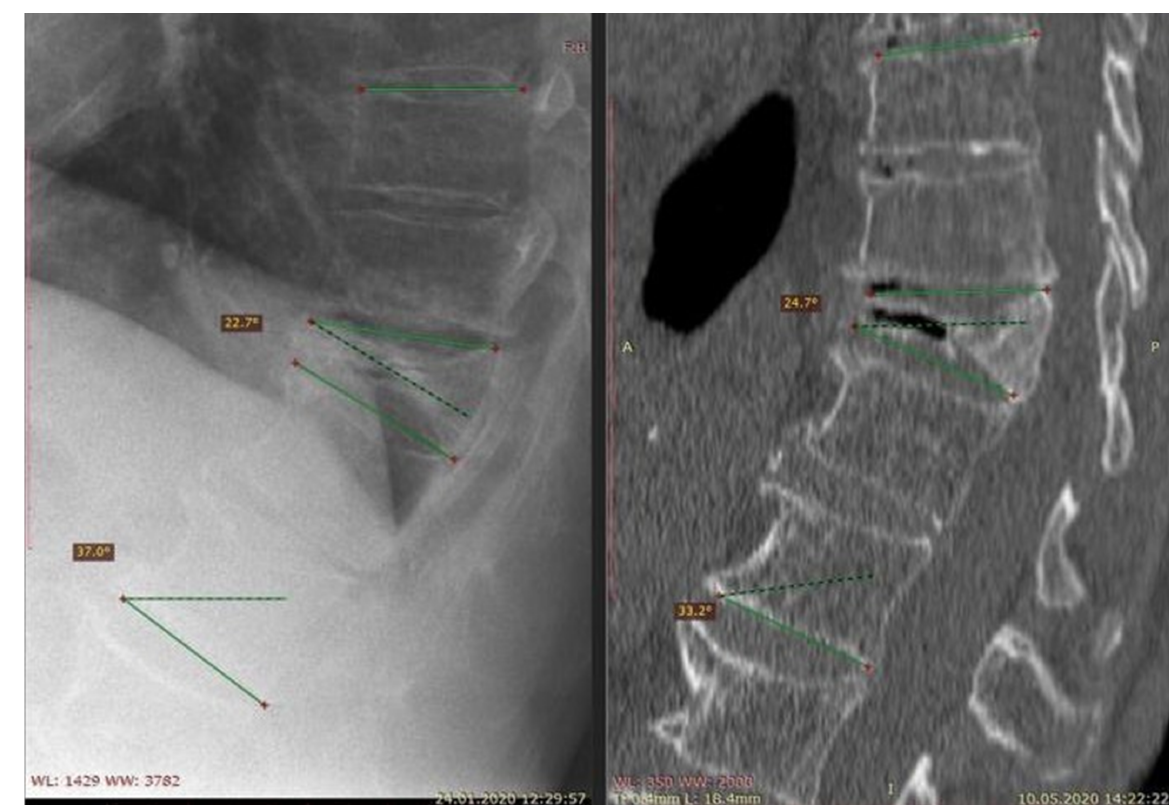
Figure 1. Images (from the left a X-ray and a CT scan respectively) of a vertebra injured from OVCF after conservative treatment failure.